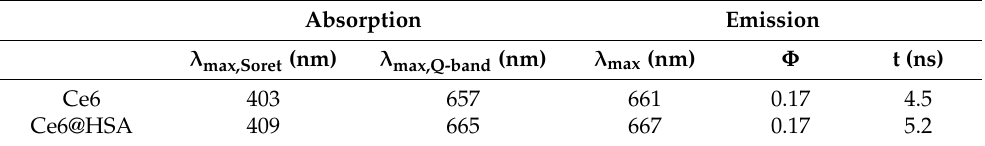
Table 2. Main photophysical parameters of Ce6 and Ce6@HSA in PBS at room temperature.